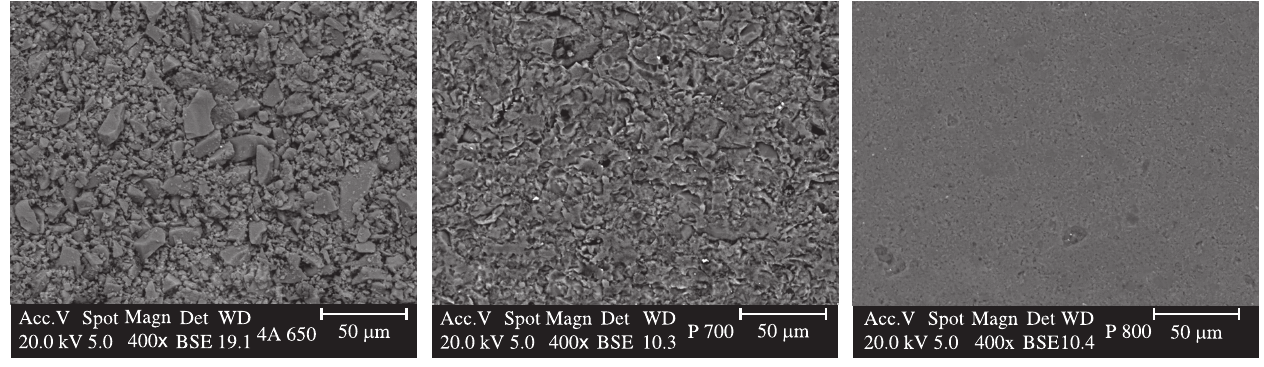
Figure 6. SEM observation of the microstructural evolution of the investigated composition during the sintering process at: (a) 650 °C; (b) 700 °C; and (c) 800